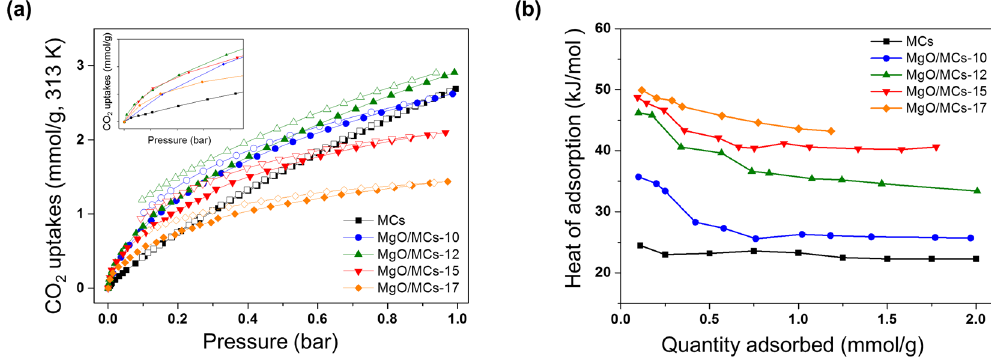
Figure 6. ( a ) CO 2 adsorption/desorption isotherms of the preparation samples at 313 K. Inset indicates CO 2 adsorption isotherms at low relative pressure (below the 0.05 bar). ( b ) Heat of adsorption on CO 2 using Clausius–Clapeyron